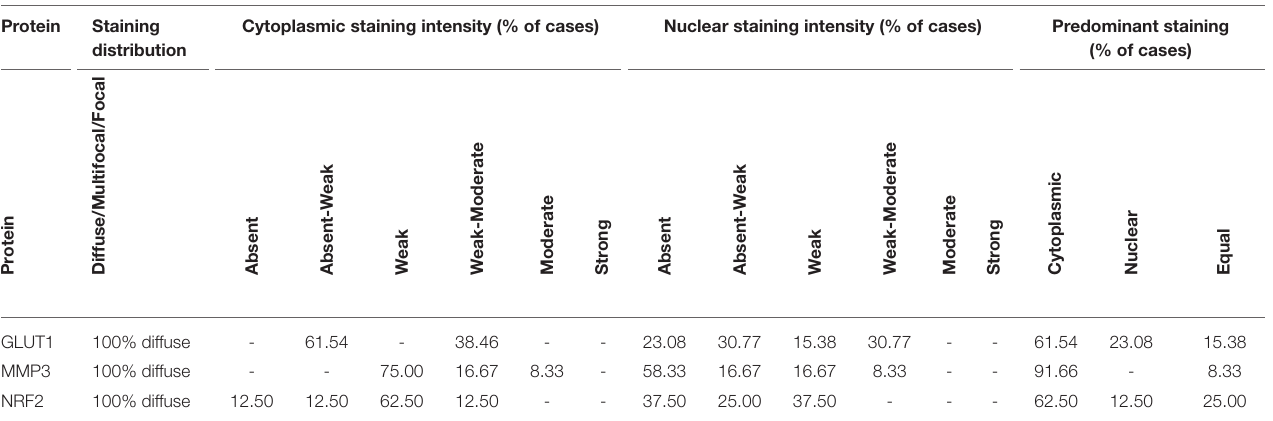
TABLE 2 | Overall blinded histopathology assessment for each OSA case.